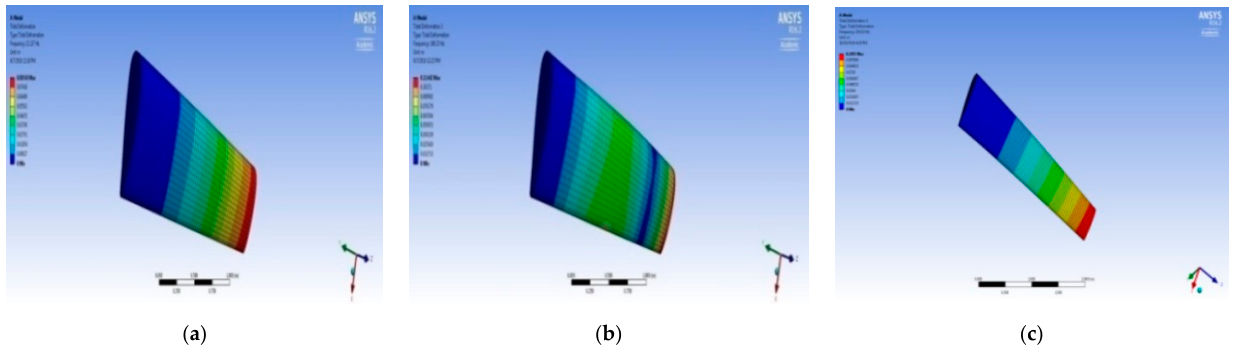
Figure 17. Deformed structures of Al-alloy, GFRP, and CFRP respectively—vibrational outcomes. ( a ) Vibrational displacements of airplane wing imposed with Al-alloy. ( b ) Vibrational displacements of airplane wing imposed with GFRP. ( c ) Vibrational displacements of airplane wing imposed with CFRP.